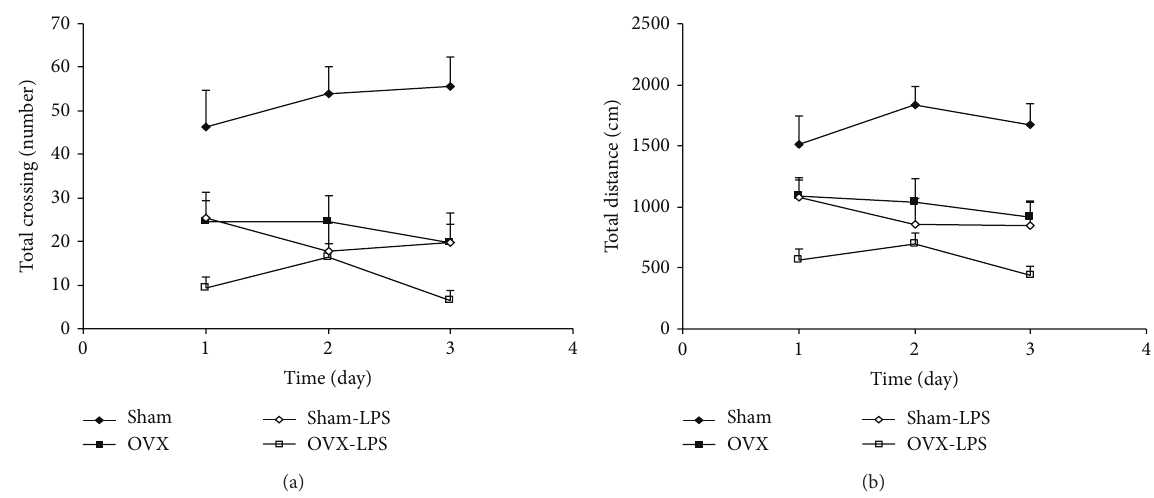
Figure 4: Comparison of total crossing number (a) and the total traveled distance (b) in the open field test between four groups. Data are expressed as mean ± SEM ( 𝑛 = 10 in each group). The total number of crossing and the total traveled distance in the OVX and Sham-LPS groups were lower than that of the Sham group ( 𝑃 < 0.01 – 𝑃 < 0.001 ). The total crossing number and the total traveled distance by the animals of OVX-LPS group also was lower than that of OVX group ( 𝑃 < 0.05 ).